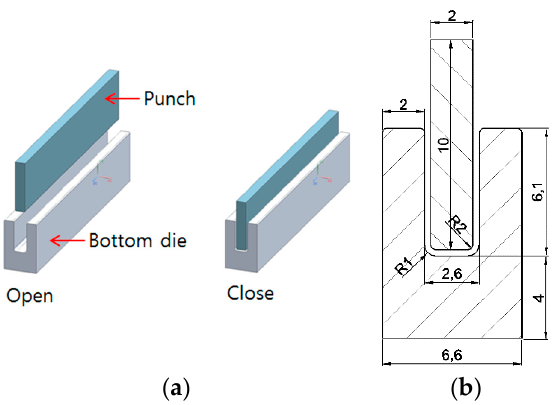
Figure 2. Shape of die and punch for forming simulation: ( a ) 3D and ( b ) 2D (unit: mm).